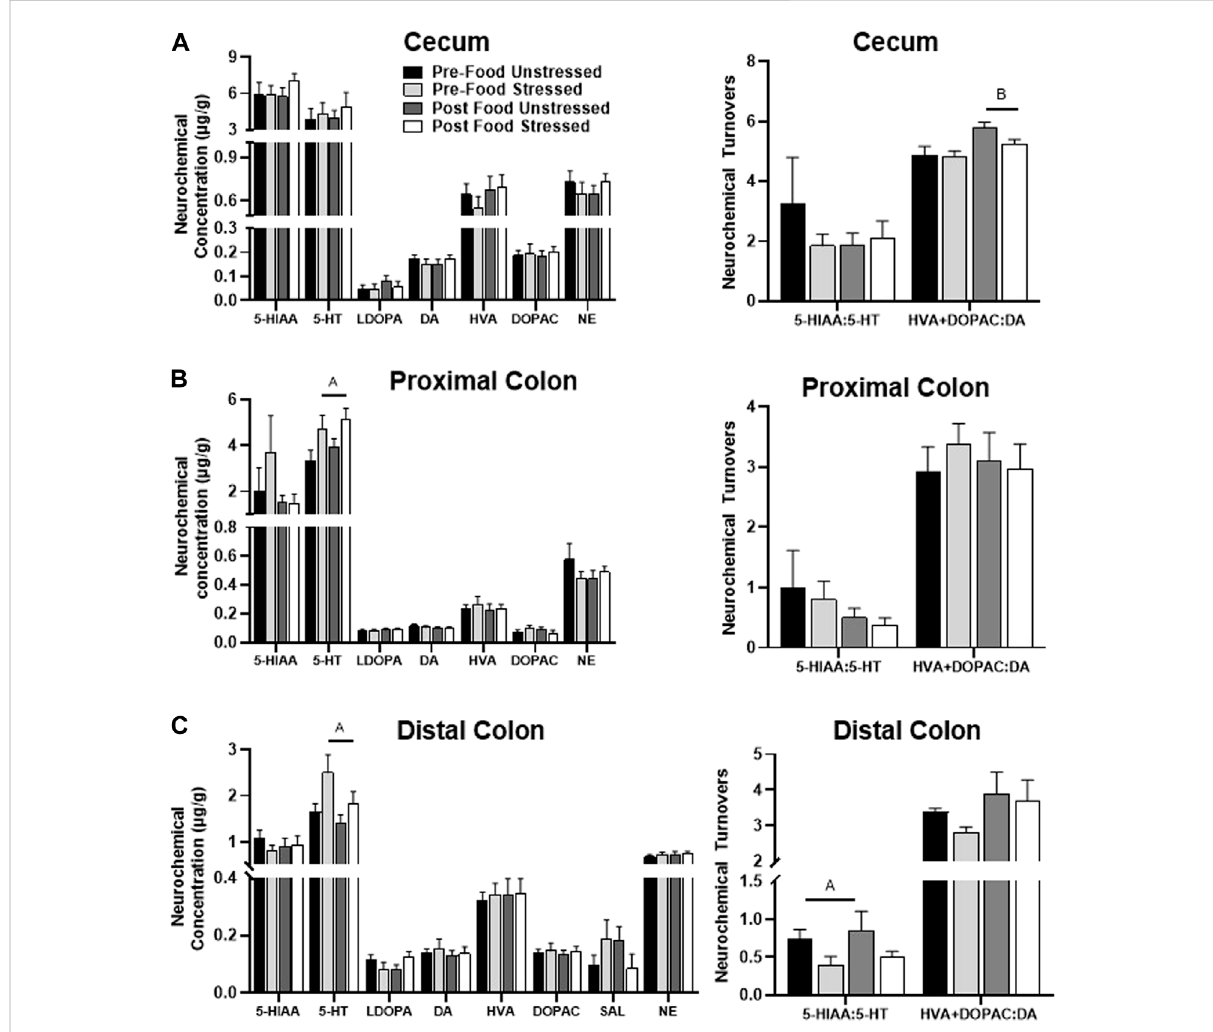
FIGURE 3 Monoamine-related neurochemical changes in the large intestines 48 h after stress exposure. (A) DA turnover measures were mildly elevated followingfoodaccess(rightpanel),howevernoneurochemicalresponsestostresswereobservedinthececum. (B) Stressexposureincreased5-HT concentrations (left panel) inthe proximal colon. (C) Stress exposure increased 5-HT concentrations (left panel) with lower 5-HT turnover measures (right panel) in the distal colon. ±S.E.M. signi fi cant main effect of stress (A) or food access (B) from Two-Way ANOVA. Signi fi cance p < 0.05. Sample size n = 9 per group, except Post Food Stress group n =